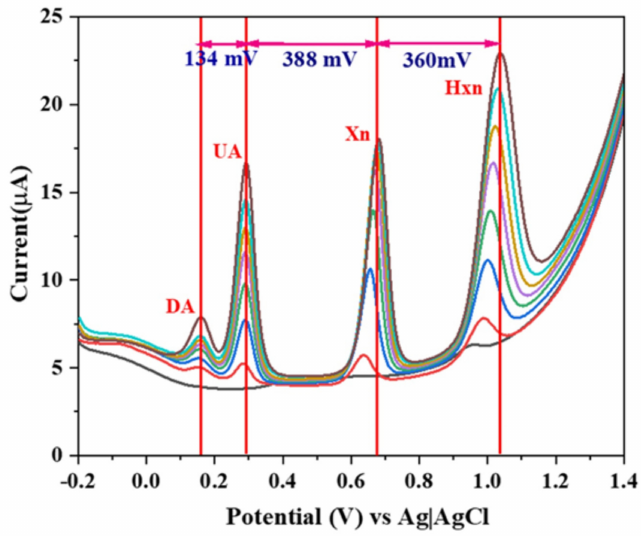
Figure 7. DPV response of a β -NaFeO 2 -modified carbon paste electrode at different concentrations of DA (from red to black curve 10 nM to 70 nM), UA (from red to black curve 5 µ M to 200 µ M), Xn (from red to black curve 5 µ M to 200 µ M), and Hxn (from red to black curve 5 µ M to 200 µ M) [55]. Reproduced with the permission from